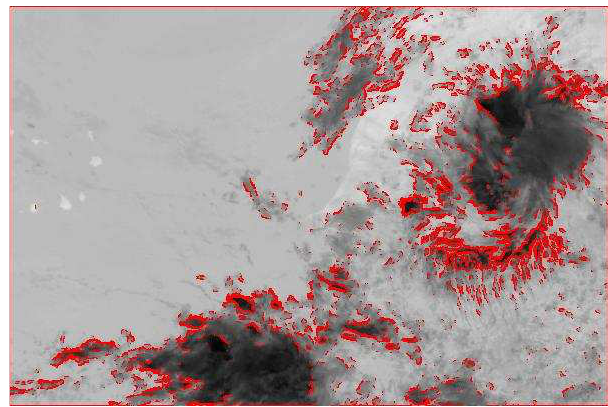
Fig. 3. The 5% highest local variance values are plotted in red on Figure 3. The 5% highest local variance values are plotted in red on the 8.7 µm channel image the 8.7µm channel image (20 ◦ N–11 ◦ N/26 ◦ W–12 ◦ W). The local (20°N-11°N/26°W-12°W). The local variance has been computed on a 3x3 window. variance has been computed on a 3 × 3